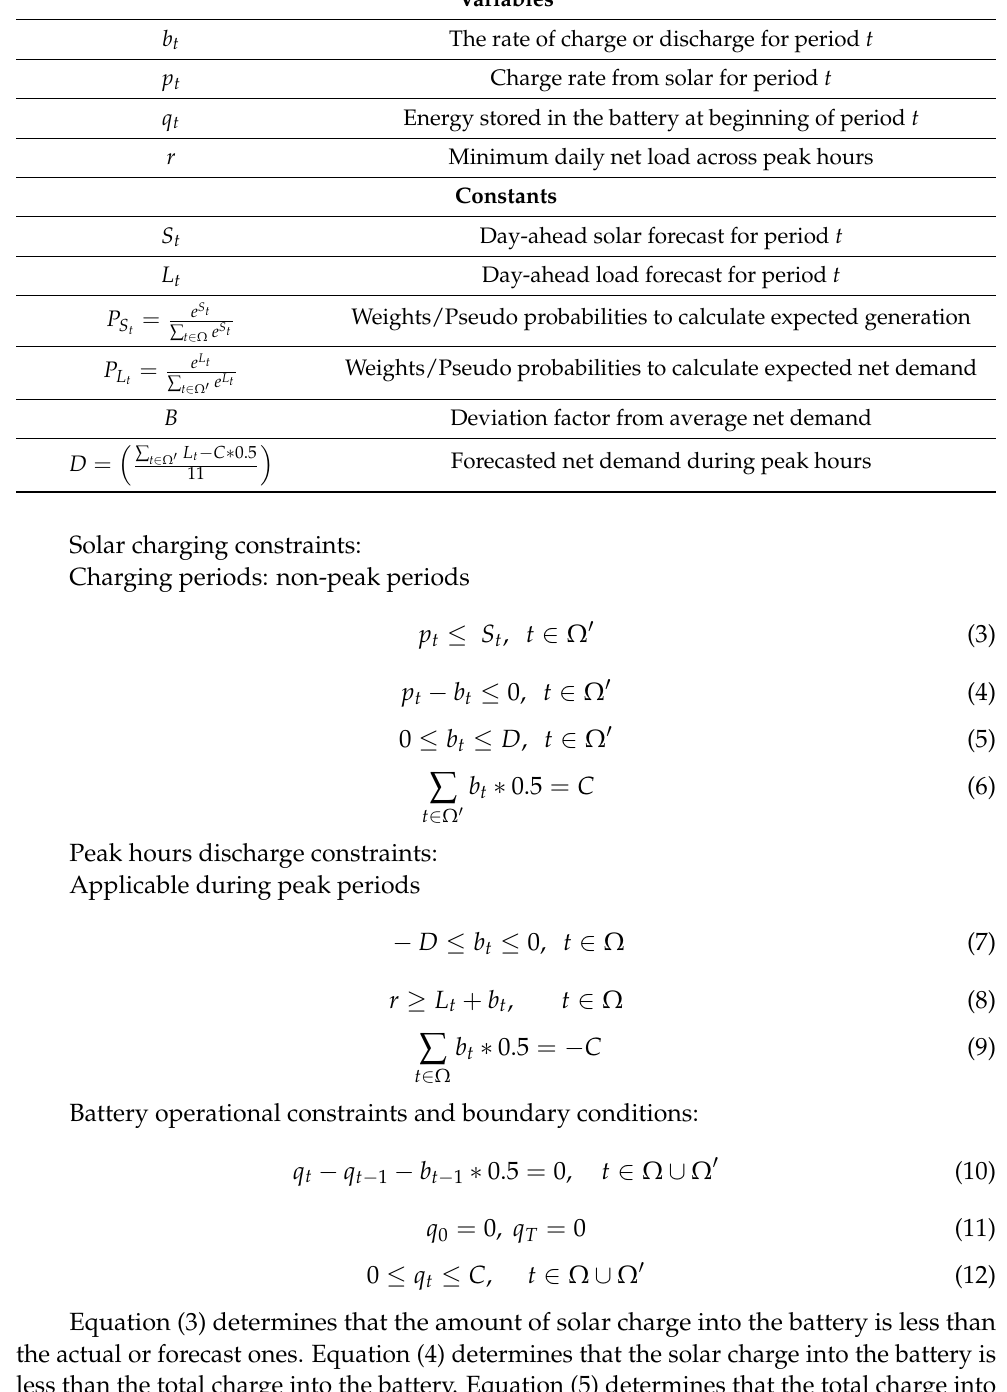
Table 2. Table of Notations.